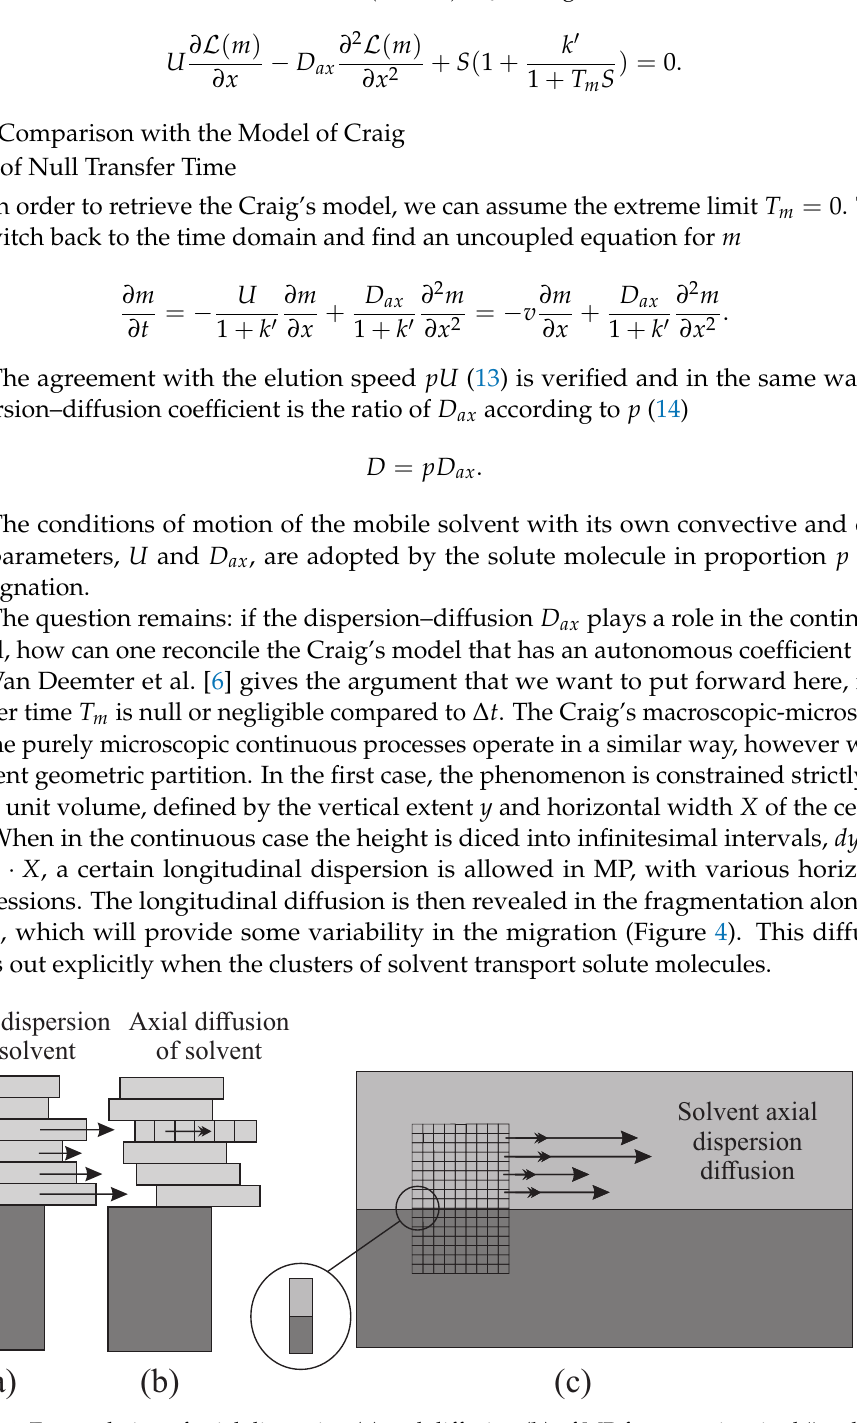
Figure 4. Extrapolation of axial dispersion ( a ) and diffusion ( b ) of MP from a re-inspired “exploded” Graig’s cell. The equivalence of the Craig’s model with the continuous model ( c ) is found on a two-phase infinitesimal element (in